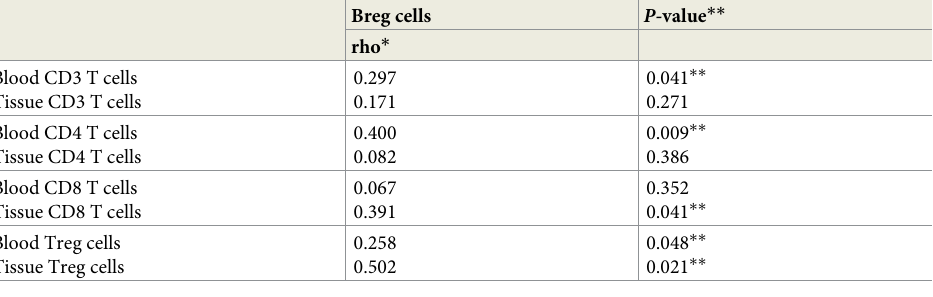
Table 6. Correlation between Bregs level and peripheral T-cell